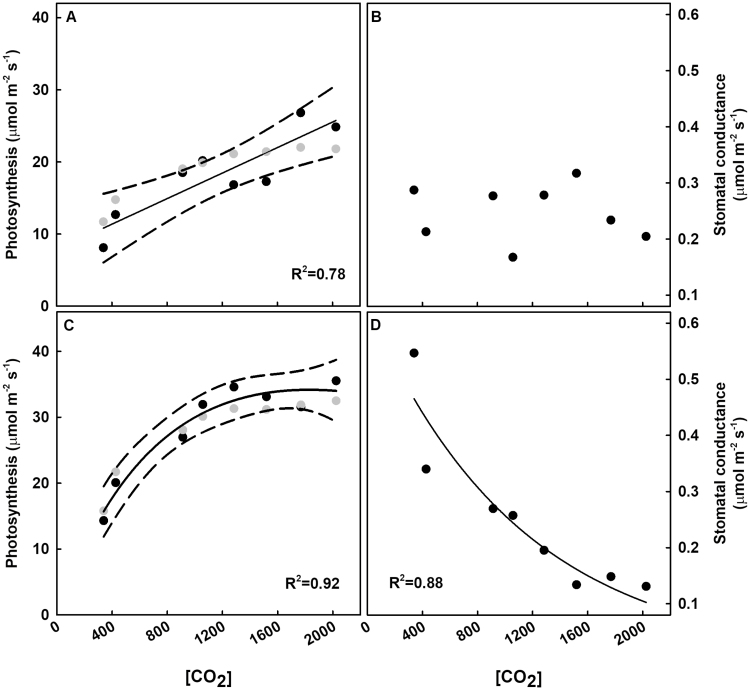
Midday soybean leaf gas exchange with [CO2]. Mean midday photosynthesis (A, C) and stomatal conductance (B, D) on the 16th (A, B) and 30th (C, D) day after emergence. Black symbols are the mean of three plants per treatment. Gray symbols (A and C) are modeled photosynthetic rates. Statistically significant relationships (P<0.1) as a function of [CO2] are indicated by a fit plotted through the data (solid line) and the 95% confidence limits (dashed line) for statistical comparison of modeled to measured photosynthetic rates. The R2 values are indicated in the figure.